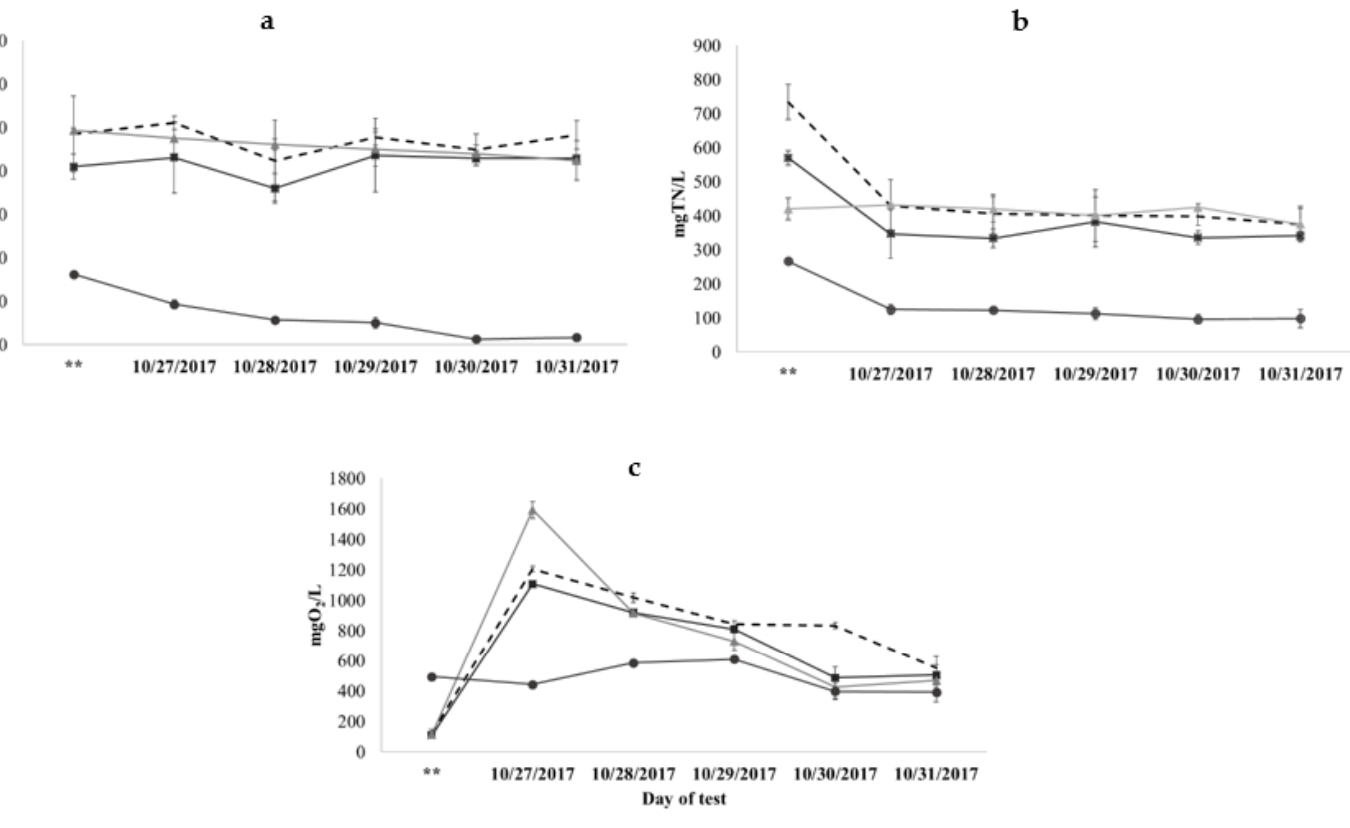
Figure 6. The mean ( a ) nitrate-nitrogen, ( b ) total nitrogen, ( c ) chemical oxygen demand concentrations mg / L after the addition of a carbon source by means of a glucose solution. ( ** ) first sampling day controlled prior the addition of glucose solution. Treatment A (constant aeration), Treatment B (intermittent aeration 4h AA:4h no-AA), Treatment C (intermittent aeration 6h AA:4h no-AA), Treatment D (no aeration), AA = aeration.